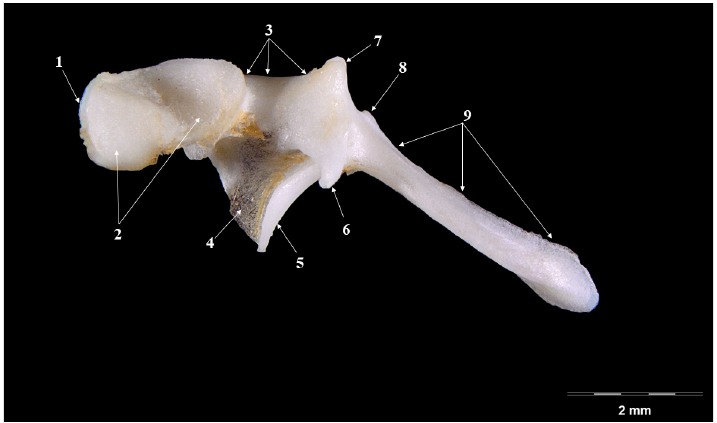
Figure 1. Malleus-Medial perspective 1. Caput mallei; 2. Processus articularis; 3. Collum mallei; 4. Ossicular lamina; 5. Process rostral; 6. Processus muscularis; 7. Processus lateralis—the upper sec- tion; 8. Processus lateralis—the lower section; 9. Manubrium mallei. Vet. Sci. 2022 , 9 , x FOR PEER REVIEW The head of malleus is slightly ovoidal in shape and it presents two parts—a lateral one (oval, slightly irregulated as surface) and a medial one (with the articular surface for the incus). The articular incal surface with a medio-caudal orientation displays two por- tions: a dorsal and a ventral one, forming an obtuse angle.